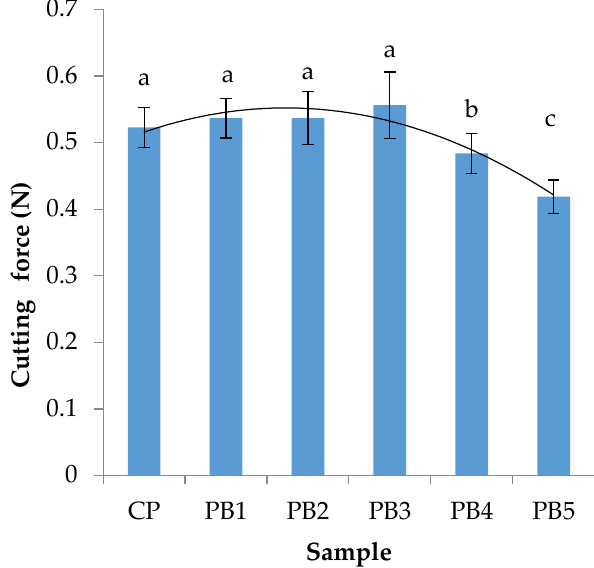
Figure 2. Relationship between cutting force of pasta and the amount of dried banana. PB1, PB2, PB3, PB4, PB5, pasta with 1%, 2%, 3%, 4% and 5% of dried and powered banana. Values followed by different letters are significantly different ( p < 0.05).